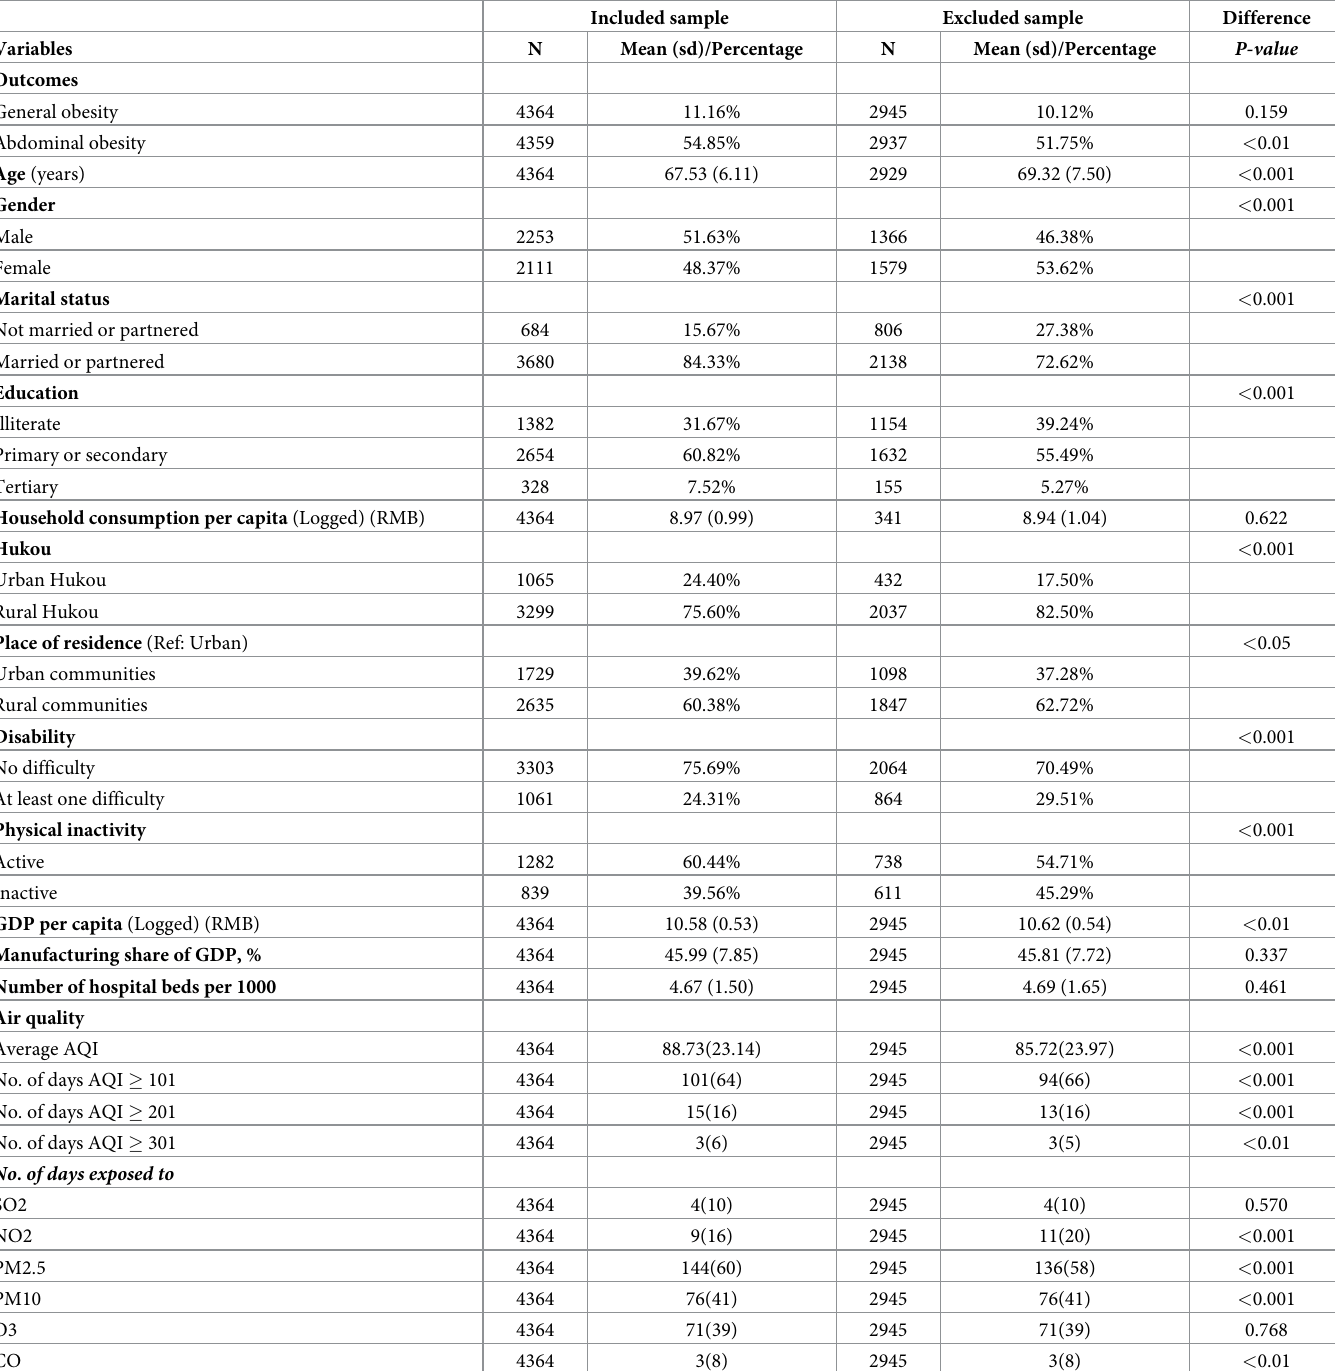
Table 1. Sample description of included and excluded older adults from the China Health and Retirement Longitudinal Study